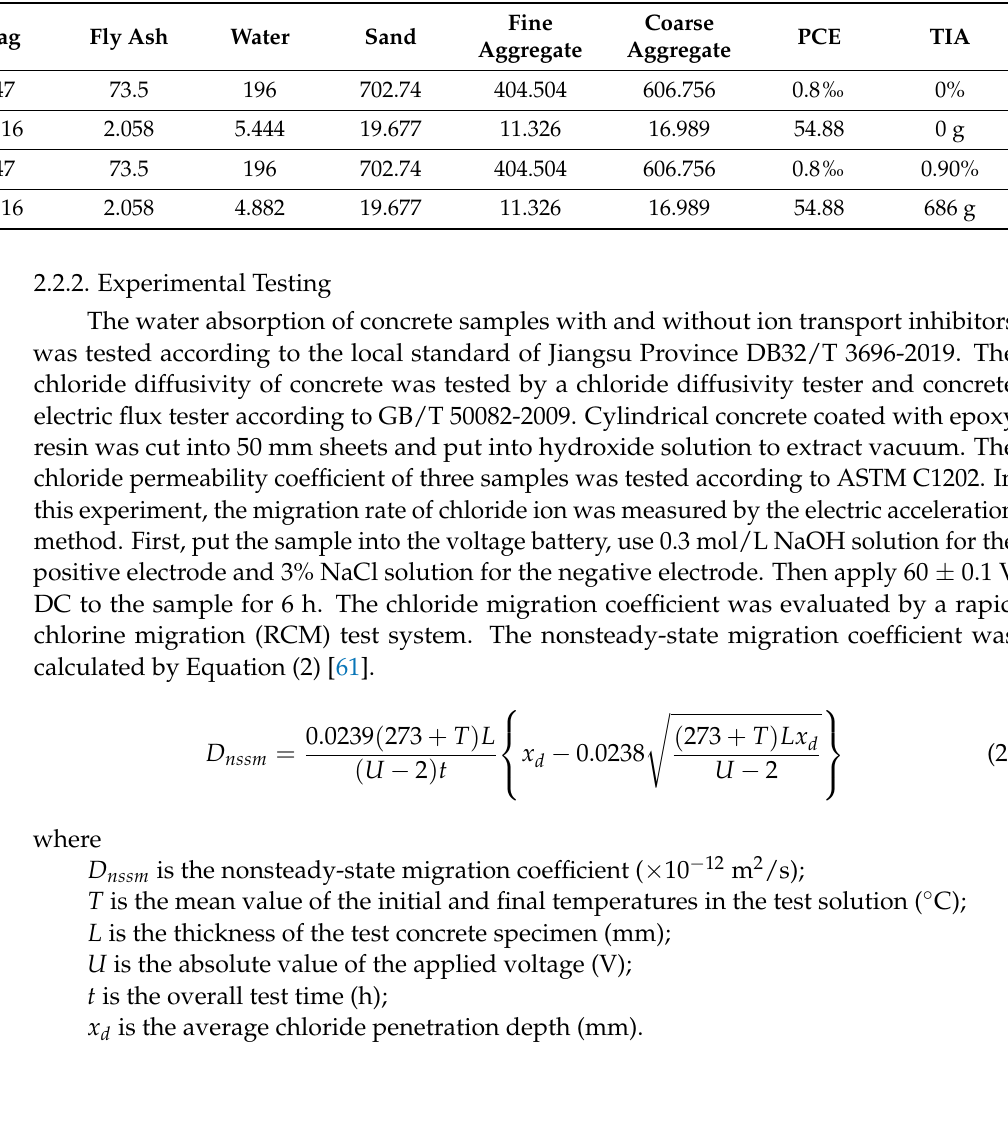
Table 2. Mix design of concrete (kg/m 3